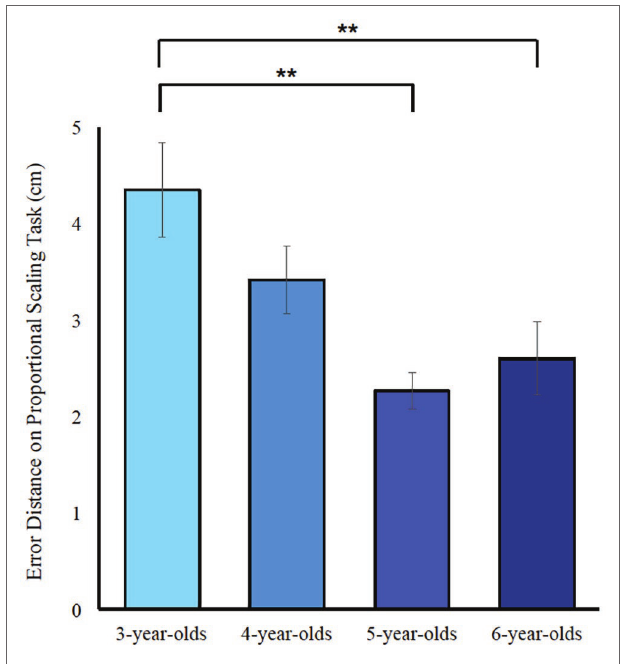
FIGURE 3 | Paired-comparisons, Bonferroni adjusted for multiple comparisons, depict between-age group differences on children’s performance on the proportional scaling task, where errors produced decrease as age increases. Error bars reflect SEM. Asterisk symbols indicate significance at an alpha level p <